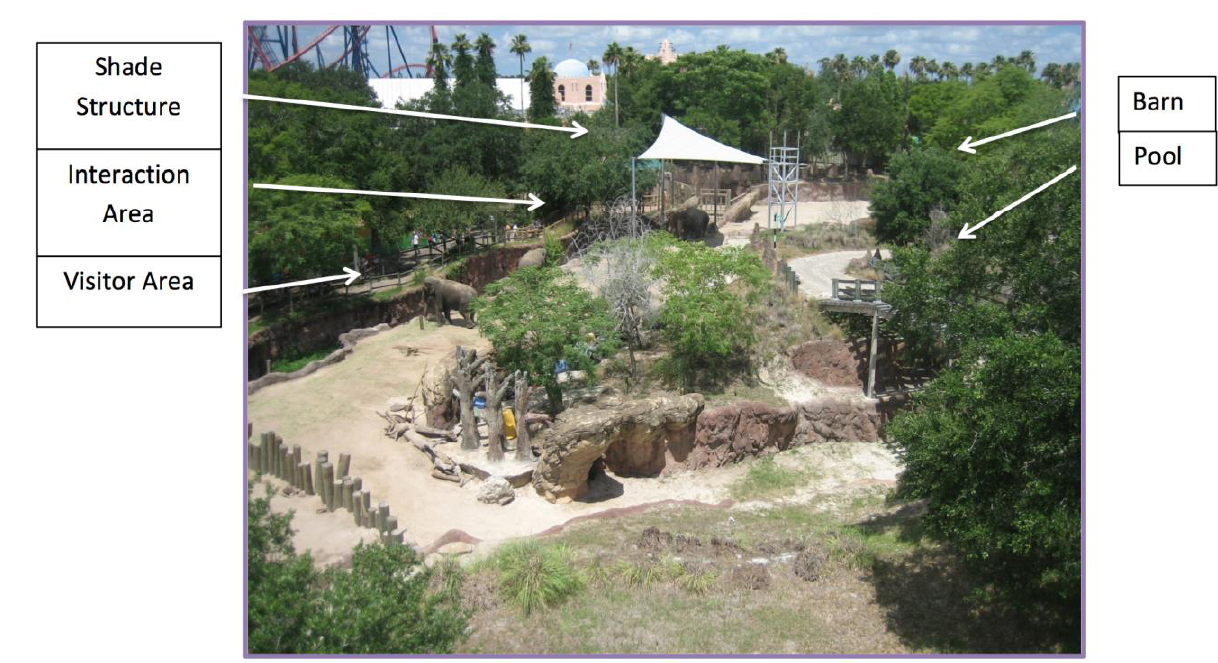
Figure 1. Image of elephant